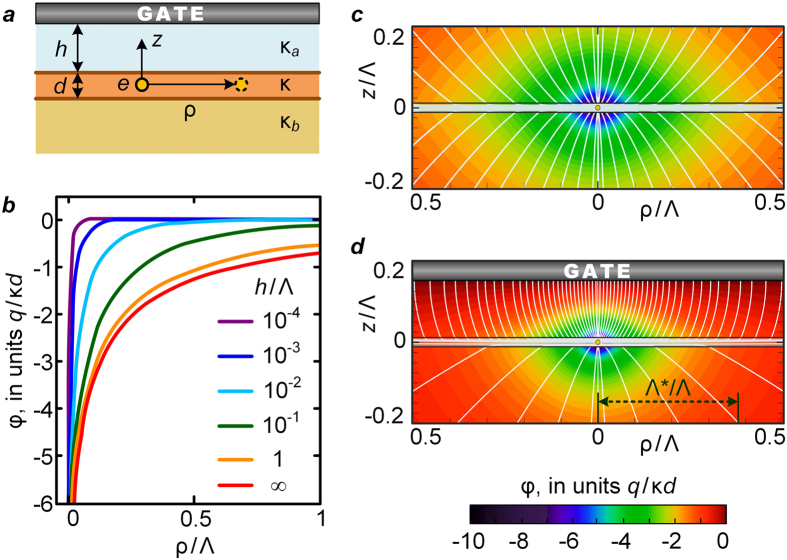
System geometry and spatial distribution of electrostatic potential.(a) Thin film of thickness d with the dielectric constant κ is deposited on the substrate with the dielectric constant κb. The metallic gate on top is separated from the film by the spacer of thickness h with the dielectric constant κa. Interacting charges, e, are located in the middle of the film. The origin of the cylindrical coordinate system, ρ, θ, z, with ρ being the lateral coordinate, is chosen at the location of the charge generating the electric field; the z-axis is perpendicular to the film plane. (b) The electrostatic potential, φ, induced by the charge e < 0 as function of ρ for different distances h between film and electrode. The values of ρ and h are taken in units of the characteristic length Λ, the potential φ is taken in units q/κd where q = e/4πε0 and ε0 is the vacuum permittivity. The curves are calculated for κ = 104, κa = 1, κb = 4. (c) and (d) Electric field lines (white) and the color map of the electrostatic potential induced by charge e < 0 in the cross-sectional plane. Panel (c) displays the field and potential without the gate; panel (d) shows the same in the presence of the gate. In the panels (c) and (d) we take κ = 100, κa = 1, κb = 1.